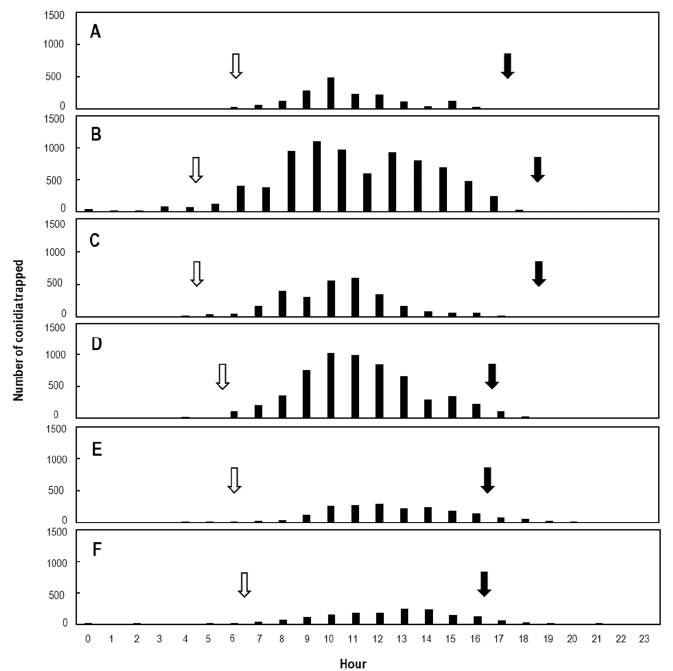
Figure 3. Time periods of conidial releases were shorter by ca. 3.0 h in December than in July. Mature conidia from single KSP-7N colonies on leaves of living strawberry seedlings at 20 days after inoculation were trapped over a period of 24 h with an electrostatic spore collector (insulator drum) in February ( A ), May ( B ), July ( C ), October ( D ), November ( E ), and December ( F ) in 2021. The data were represented in 1 h periods. Open and closed arrows indicated the times of sunrise and sunset in each month, respectively.